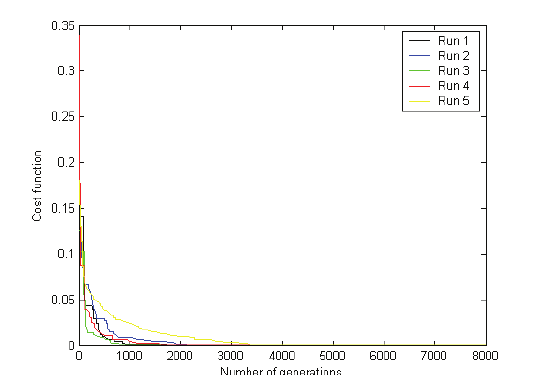
Fig. 3 Convergences of cost function for the first five runs (Run 1~Run 5).